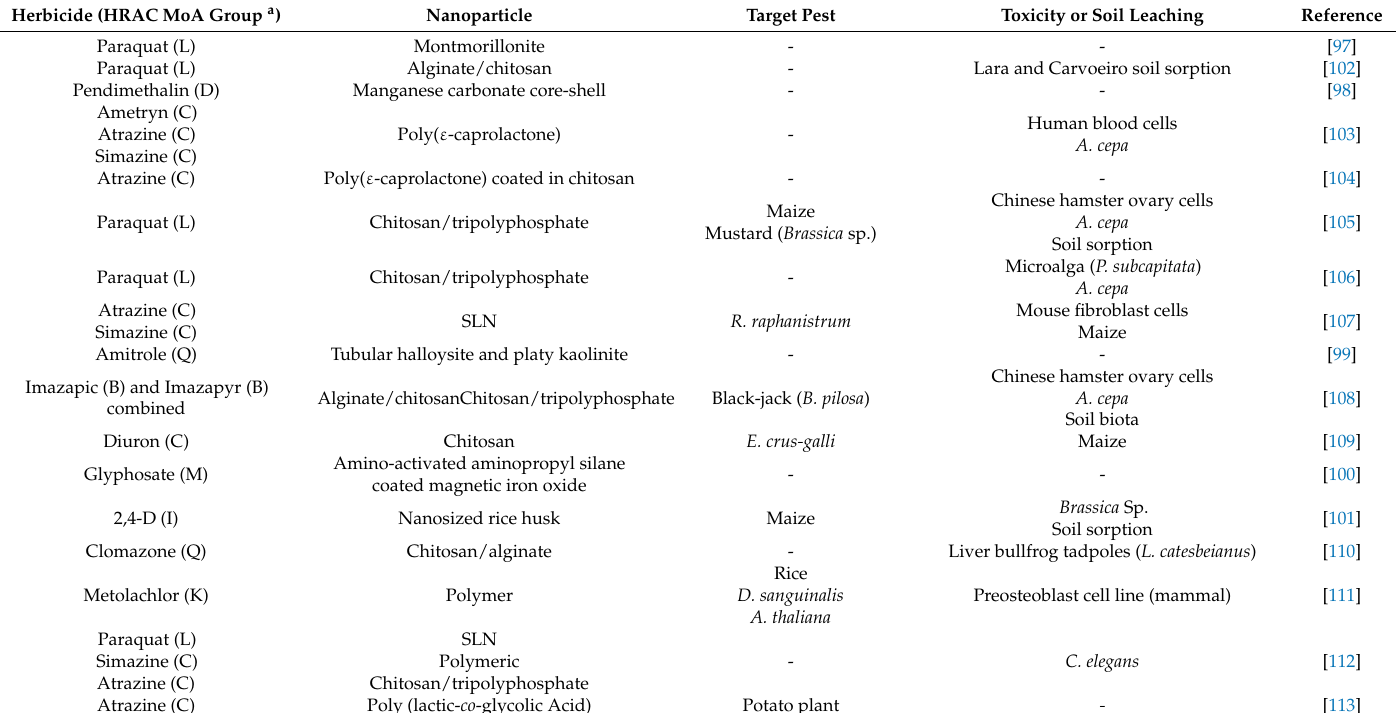
Table 3. Summary of studies utilizing nanoparticles as carriers of